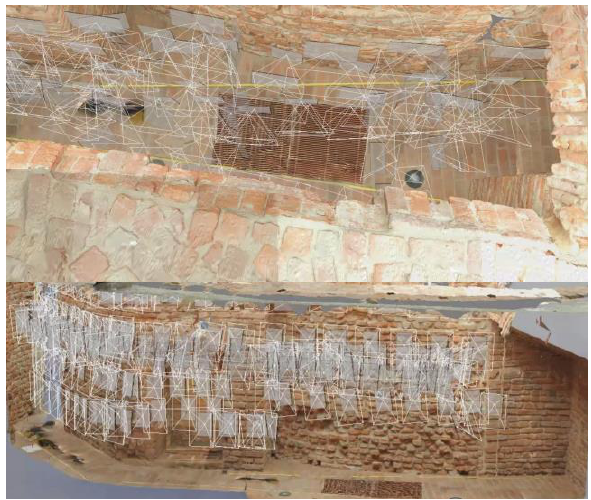
Figure 8. The unwanted effect resulting from the use of the whole image.